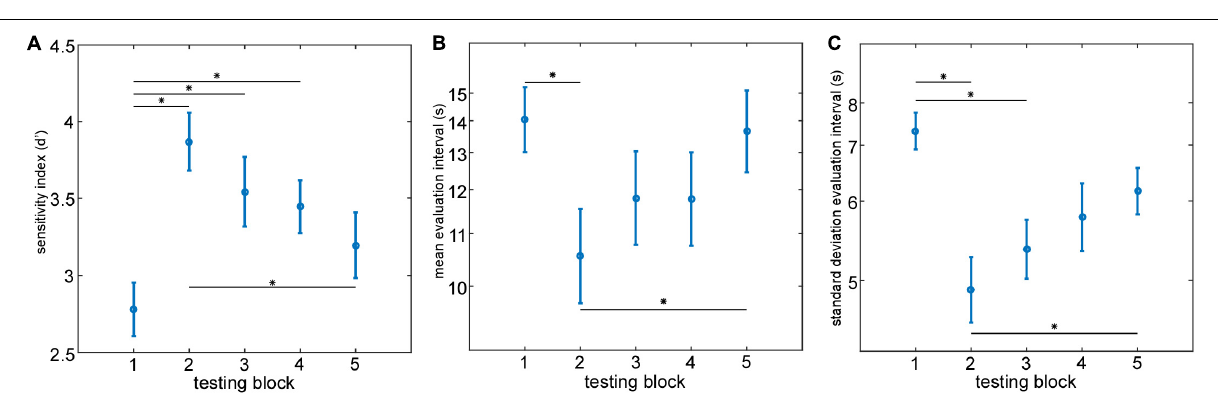
FIGURE 6 | Evaluation of individual behavioral performance and attended speaker decoding performance parameters. Group mean behavioral sensitivity index (d’) (A) , group mean evaluation intervals (B) and group standard deviation evaluation interval (C) are plotted as a function of time (testing block). Asterisks mark a significant difference between testing blocks (paired-sample t- test, p < 0.05, False Discovery Rate corrected). Error bars represent ± 1